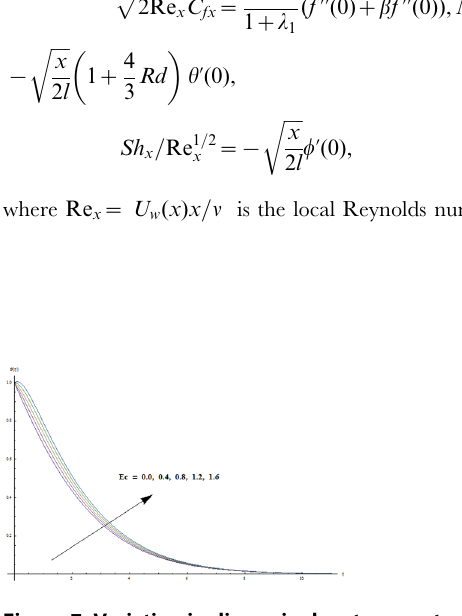
Figure 9. Variation in dimensionless concentration w ( g ) vs g for different values of l 1 when b ~ 0 : 2, M ~ 0 : 5, Pr ~ 0 : 7,